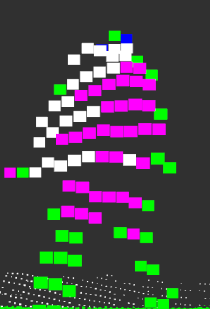
Figure 4. Illustration of false semantic segmentation.